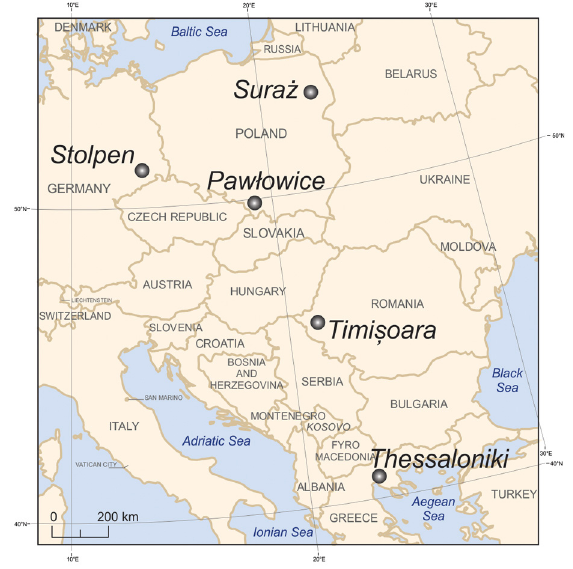
fig. 2. Case studies on the map of